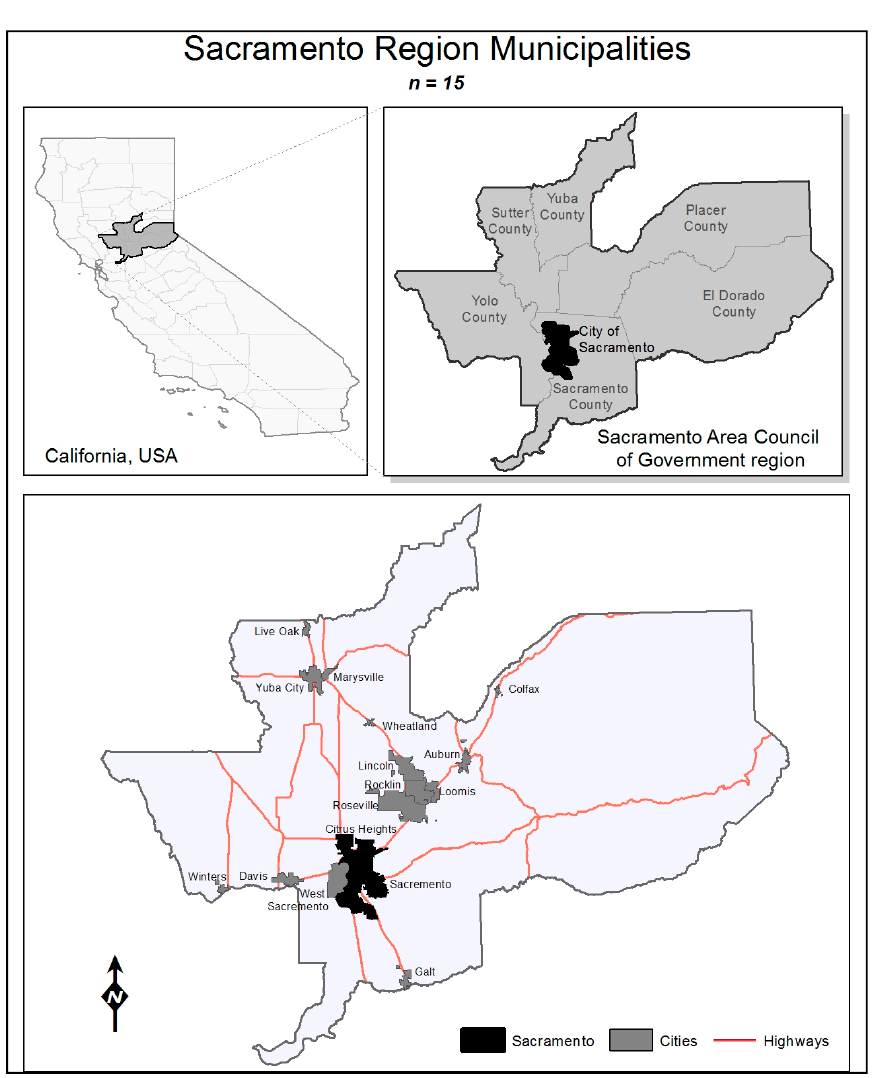
Figure 2. The Sacramento Region Subset. These cities are located in six counties and include the City of Sacramento plus 14 cities. Source: [89].